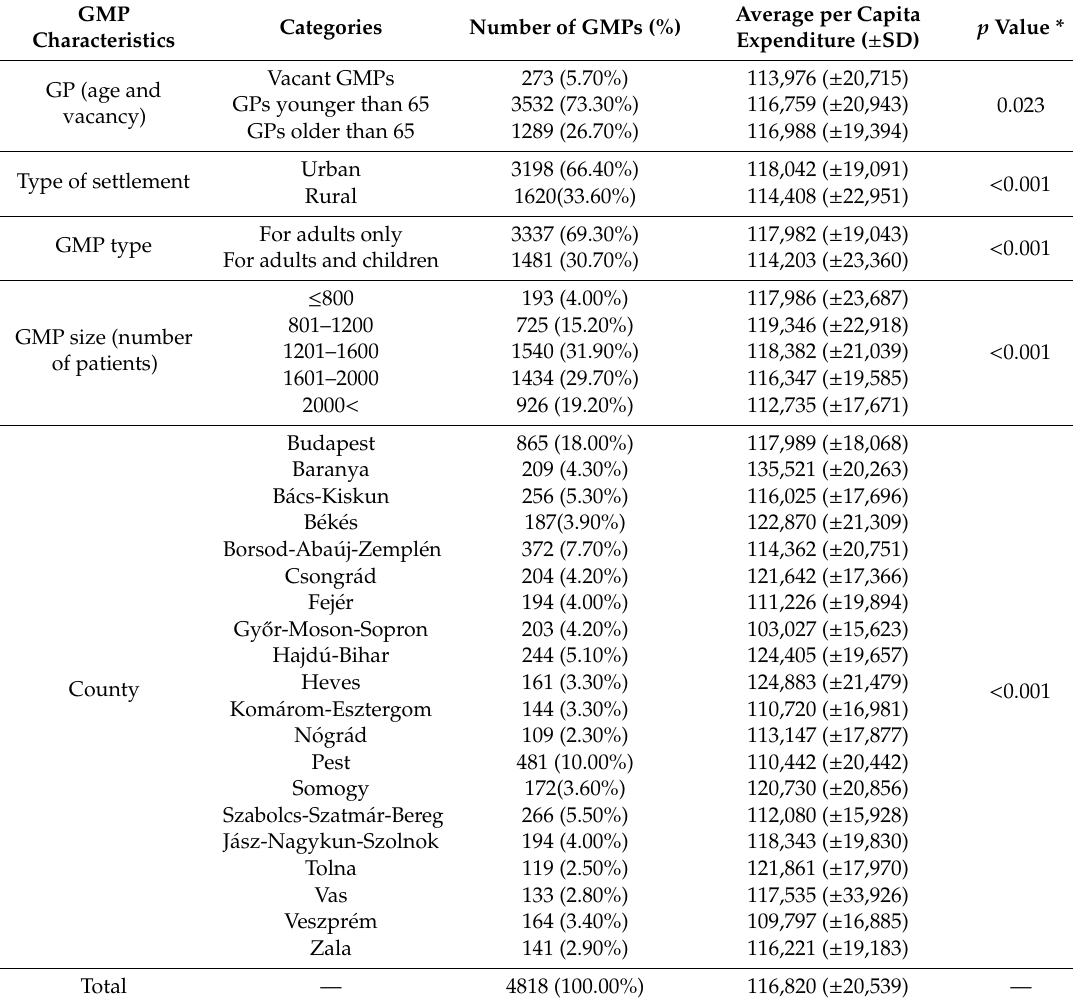
Table 2. Per-capita expenditures (in Hungarian forint) of the National Health Insurance Fund by general medical practice (GMP) structural characteristics during the period 2012–2016 in